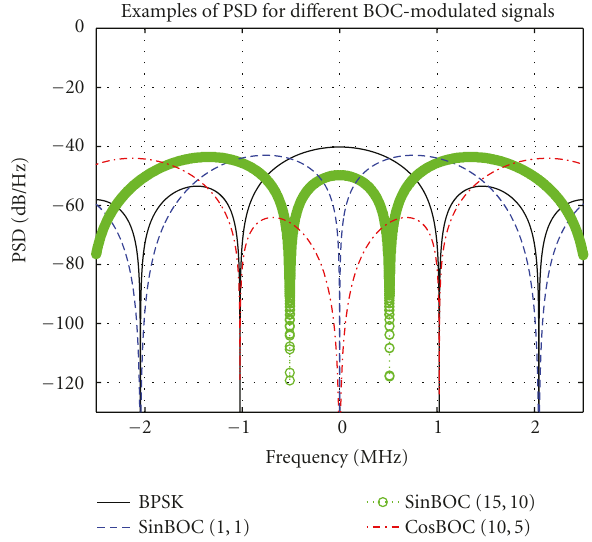
Figure 2: Examples of baseband PSD for BOC-modulated